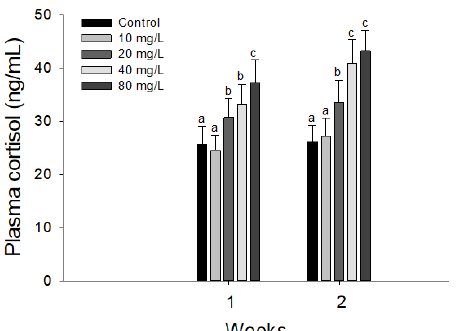
Figure 3. Changes of plasma cortisol in hybrid groupers, Epinephelus lanceolatus ♂ × Epinephelus fuscoguttatus ♀ exposed to waterborne nitrite for 2 weeks. Vertical bar denotes a standard error. Values with different superscript are significantly different ( p < 0.05) as determined by the Tukey’s multiple range test.